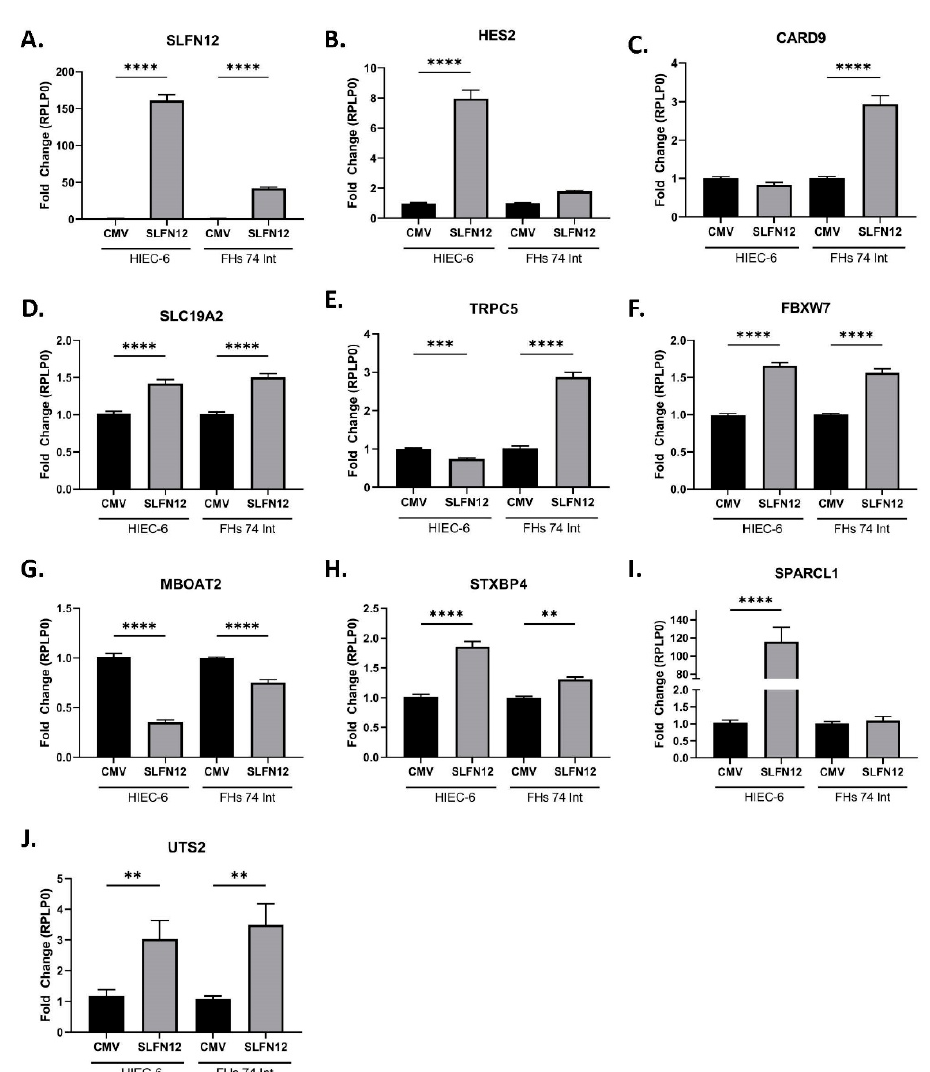
Figure 6. Overexpression of SLFN12 in human intestinal epithelial cell lines influences the expression of differentiation, restitution, and obesity-related genes. RNA expression of ( A ) SLFN12 was measured from either HIEC-6 or FHs 74 Int cells that were treated with either CMV adenovirus control or AdvSLFN12. The following genes are involved in differentiation and restitution of intestinal mucosa: ( B )